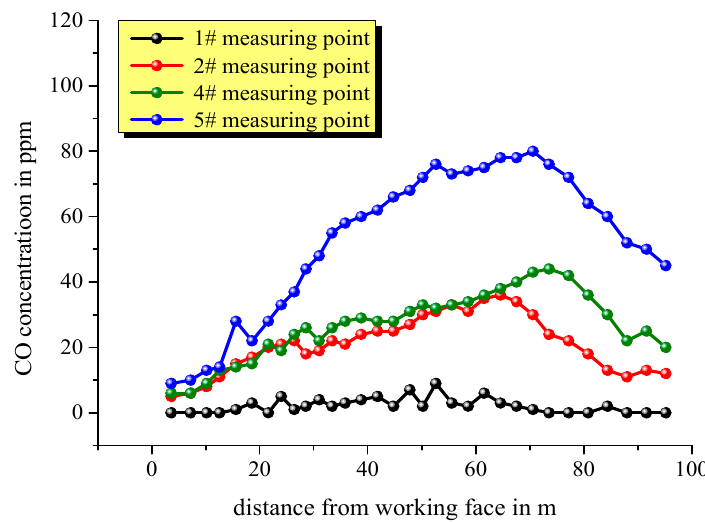
Figure 11. CO concentration for#1, #2, #4, #5 measuring points.